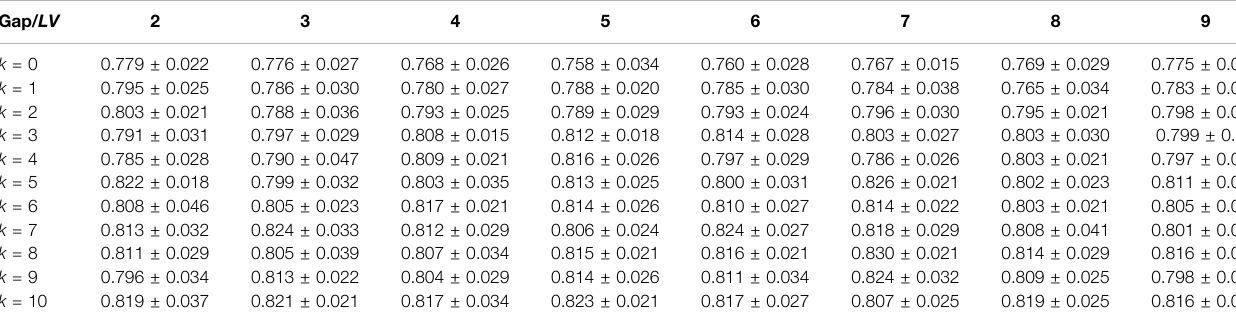
TABLE 1 | Balanced accuracy results of ablation study on Gap ( k ) and LV parameters. Gap/